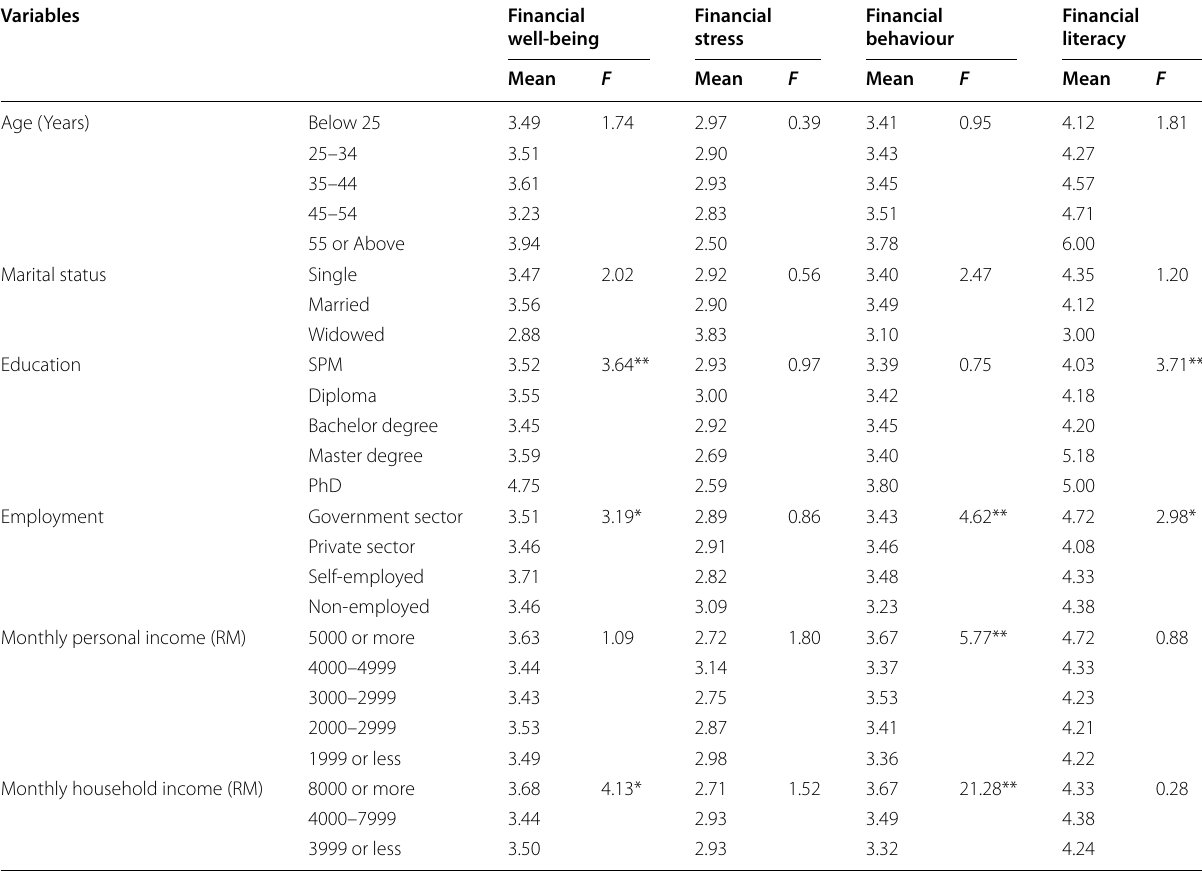
Significance at ∗ p < 0.05 ;∗ ∗ p < 0.01